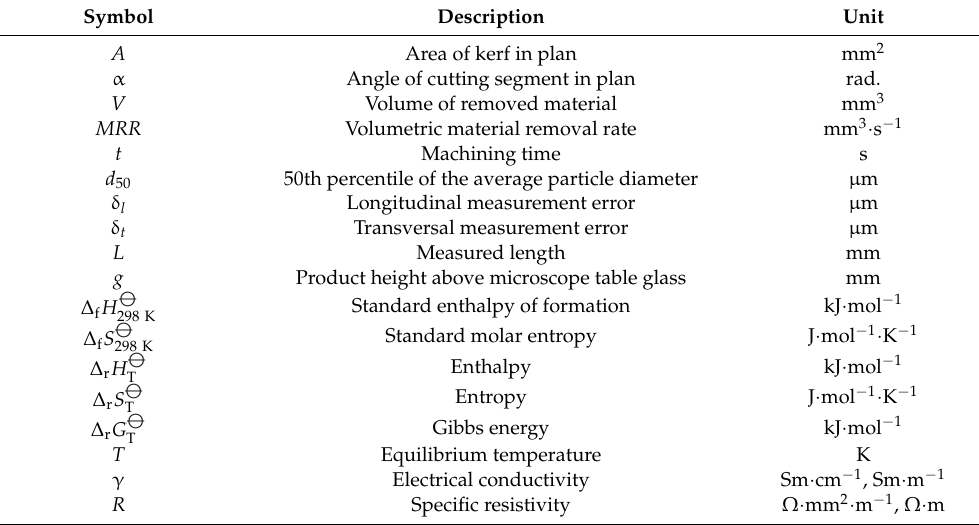
Table 15. Calculated entropy of some Ni-containing substances and equilibrium